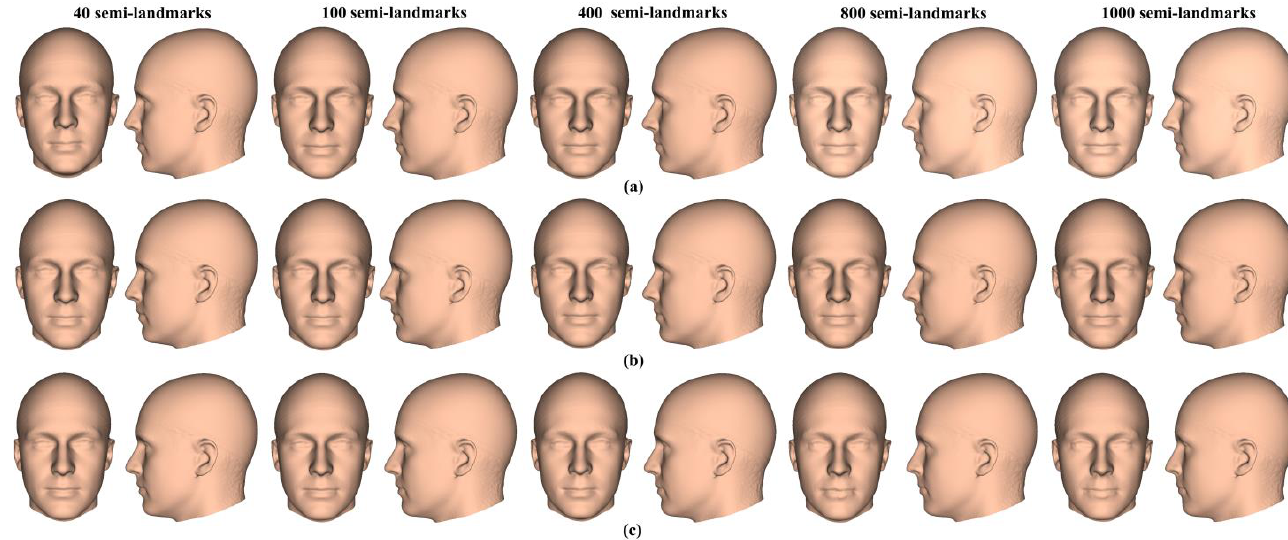
Figure 5. Visualization of the head mesh surfaces generated using different semilandmarking ap- proaches after re-semilandmarking and re-warping. ( a ) Sliding TPS. ( b ) TPS&NICP approach. ( c ) LS&ICP approach. Increasing semilandmark density from left to right. ( c ) LS&ICP approach. Increasing semilandmark density from left to